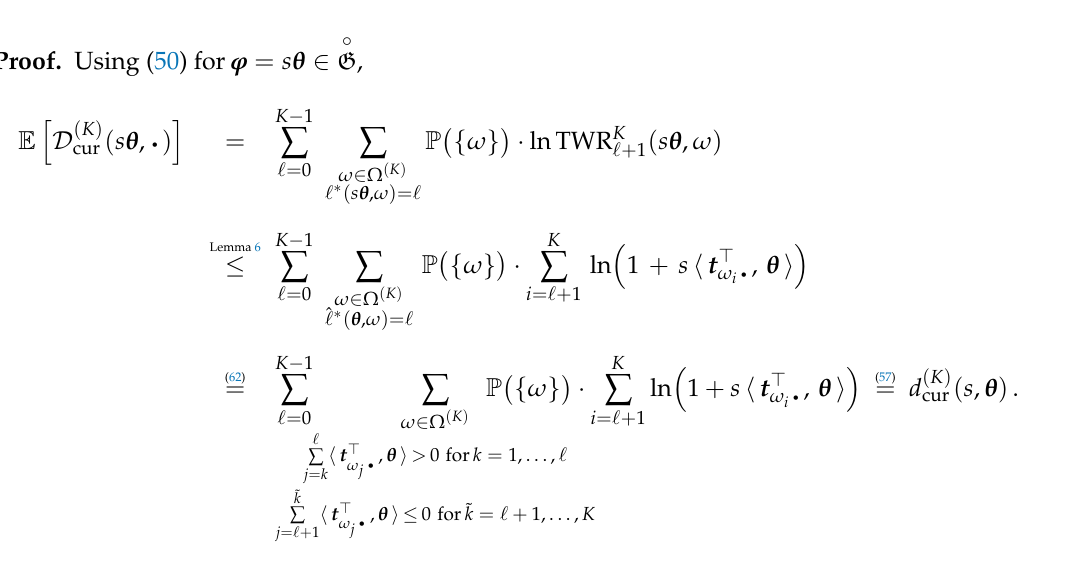
from Theorem 9 with K = 5 for Example curX